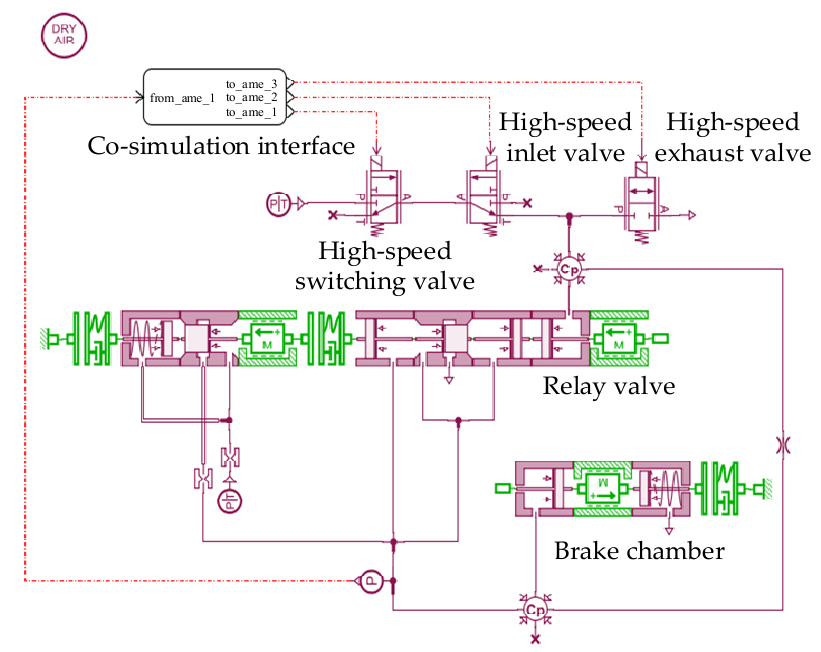
Figure 3. The AMESim model of pressure regulation characteristics of the